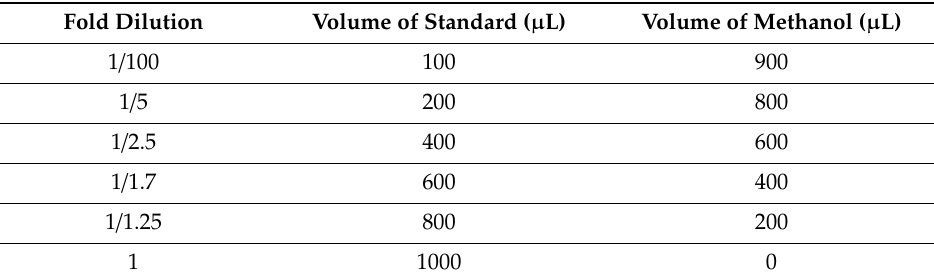
Table 4. The dilution volume for intermediate mixed standards.